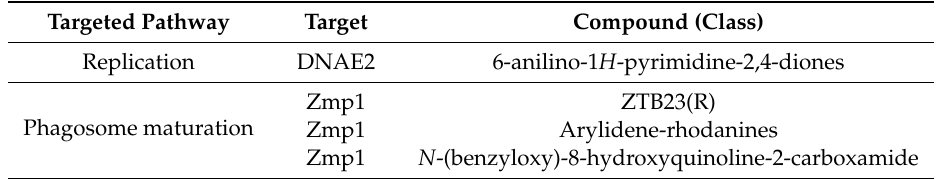
Table 2. Non-essential mycobacterial target examples and their relevant compounds or compound